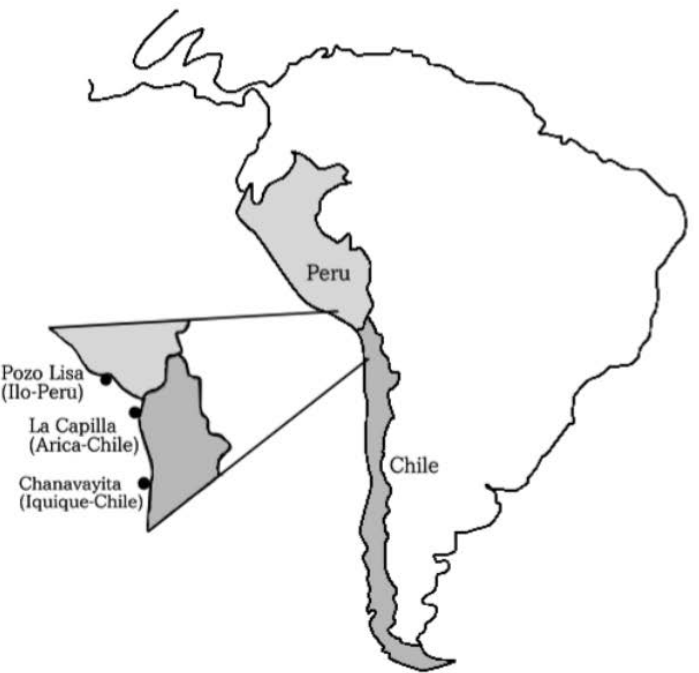
Figure 2. Sampling areas for specimens of Sarda chiliensis chiliensis : Pozo de Lisas (Ilo, Perú); Playa La Capilla (Arica, Chile); Playa Chanavayita (Iquique, Chile).